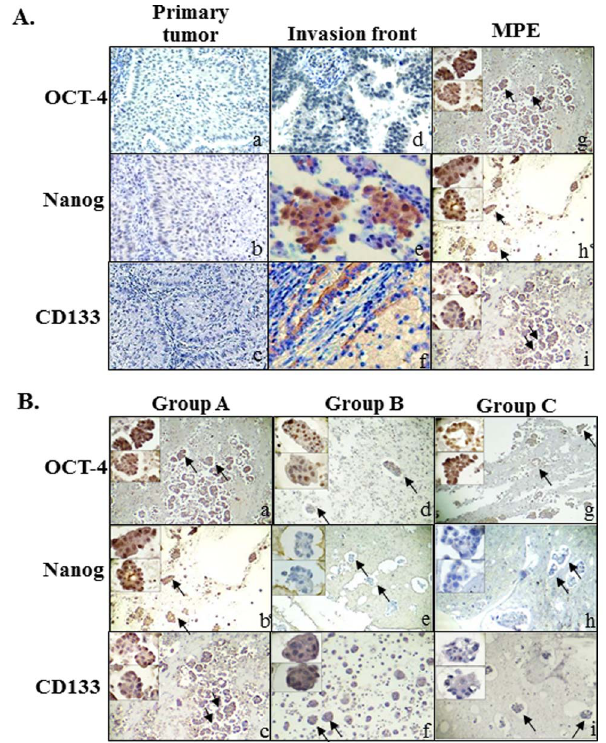
Figure 2. Characterization and distribution of CSC-representa- tive markers related to the microenvironment. (A) Immunohis- tochemical results showed immunoreactivity of three CSC-representa- tive markers (OCT-4, Nanog, and CD133) in the center of the primary tumor (a, b & c) (Magnification, 200 6 ). Stronger immunoreactivity was shown at the invasive fronts (d, e & f) (Magnification, 200 6 ) and many cancer cell clusters (arrows) in MPE at lower and higher magnifications (g, h & i). (Magnification, 40 6 and 400 6 ). ( B ) Immunocytochemical characterization of cancer cell clusters in MPE showed three major combination groups (positive OCT-4, combined with positive or negative Nanog, and CD133 expressions) were identified: Group A, positive for all three CSC-representative markers (a, b &c); Group B, positive for OCT-4 and CD133, but negative for Nanog (d, e & f); Group C, positive for OCT-4, but negative for Nanog and CD133 (g, h & i) at lower and higher magnifications. (Magnification, 40 6 and 400 6 ).